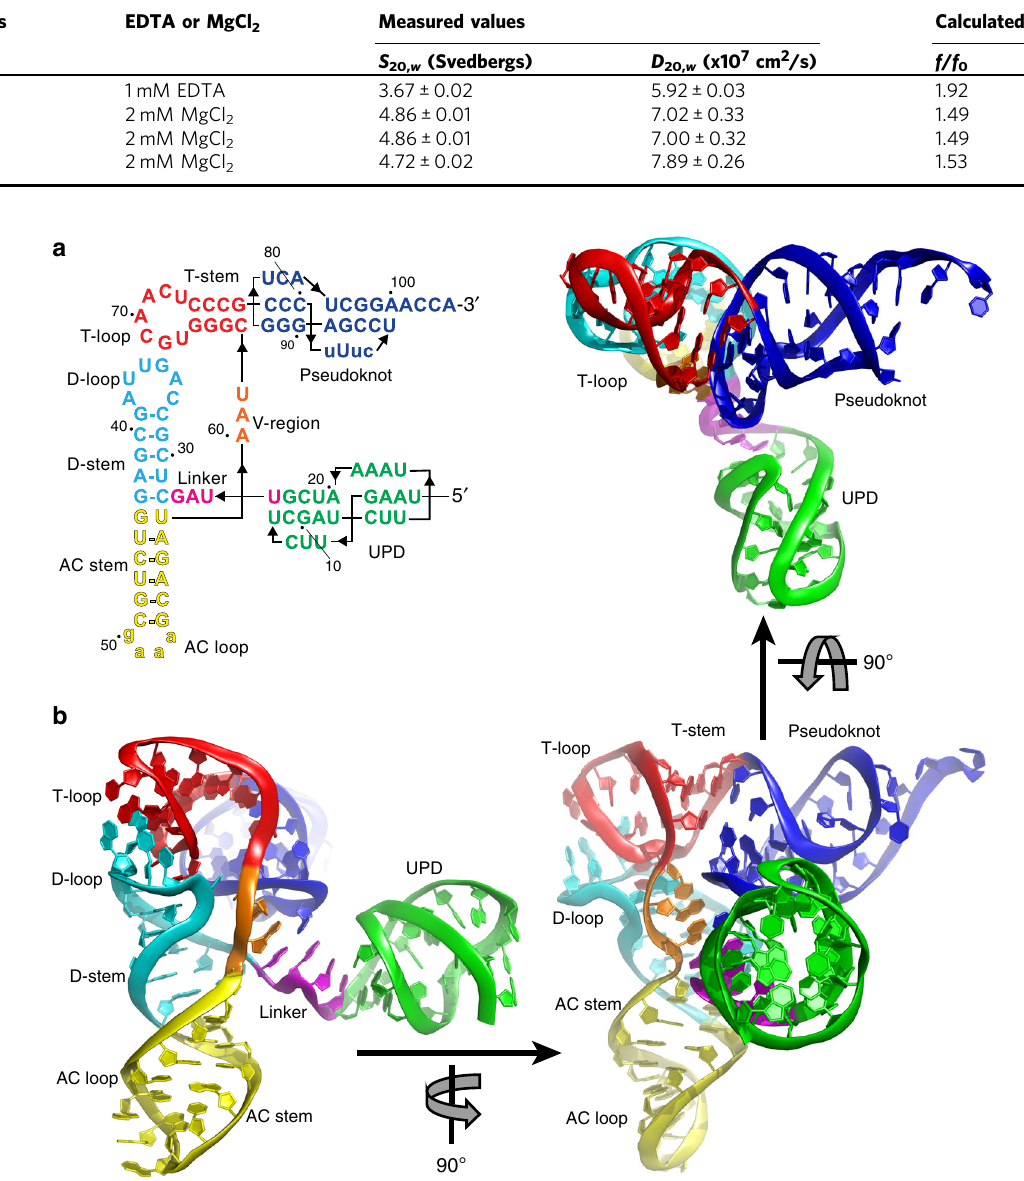
Fig. 5 TYMV 3 ′ -UTR structure. a Secondary structure of the crystallized RNA. Lowercase: sequences altered for crystallization; this includes nucleotides that enhance aminoacylation in vitro 71 . b Ribbon representation of the structure, colors match